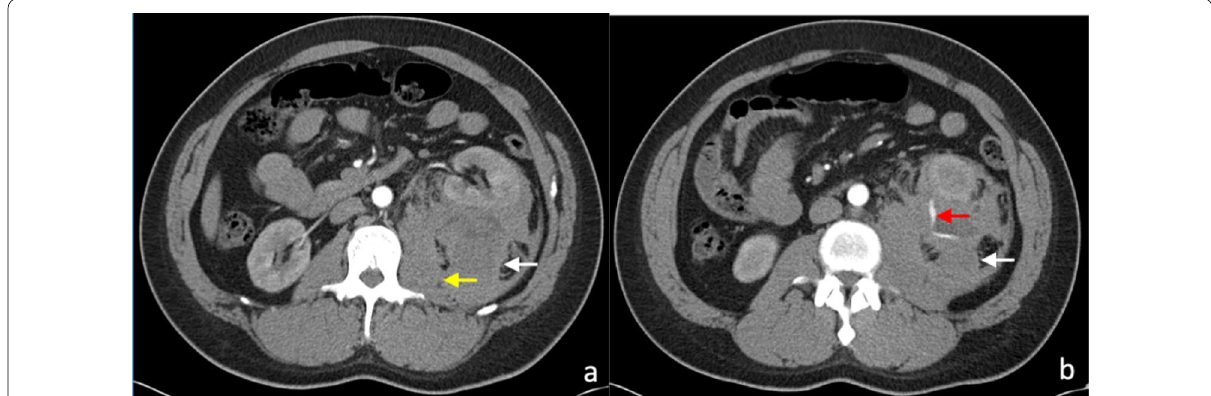
Fig. 9 Post-contrast arterial phase axial CT images of a patient following two 14-gauge non-targeted core biopsies of the left kidney, demonstrating ( a ) left perinephric haematoma (white arrow). There is also a haematoma of the left psoas muscle, which is expanded (yellow arrow). b Active extravasation of contrast from a left inferior segmental renal artery (red arrow) was demonstrated inferiorly within the perinephric haematoma (white arrow). The active haemorrhage was successfully treated with embolisation coils of the left inferior segmental renal artery. The core biopsies confirmed IgA